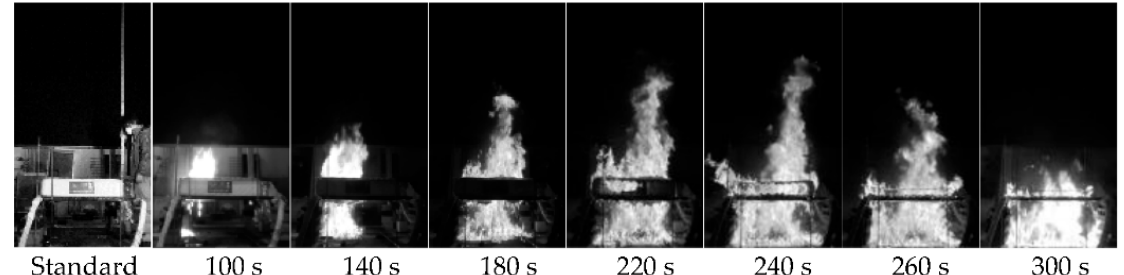
Figure 7. Flame-height images (HB 515 mm).